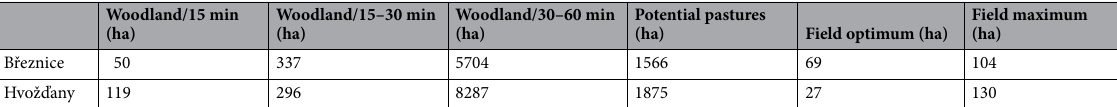
Table 1. Březnice and Hvožďany: areas that could be used as forest and pastures expected based on SCA in combination with nineteenth century maps. Potential acreage of fields is based on prediction model.